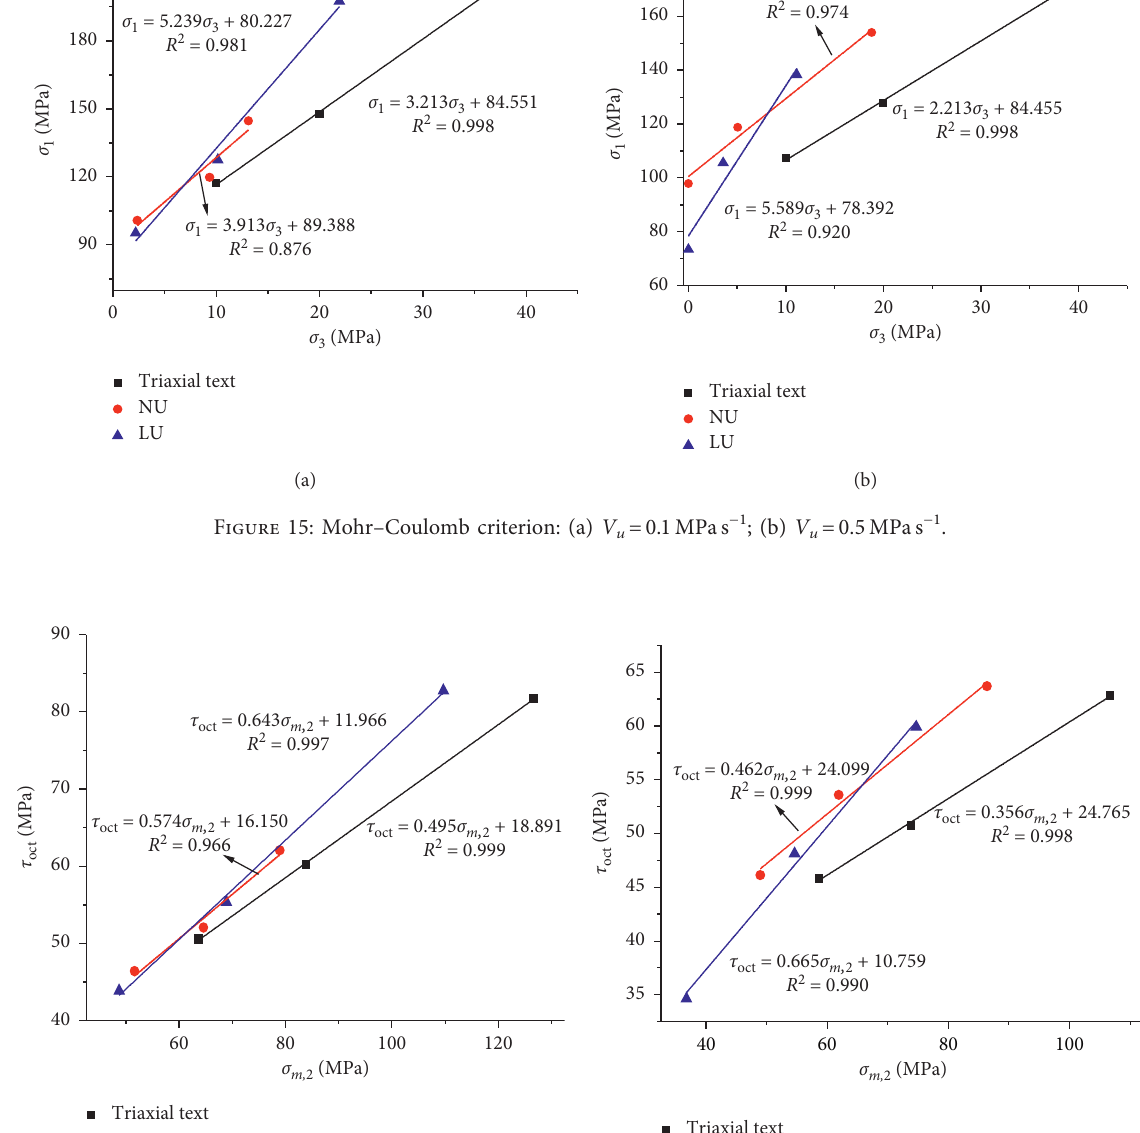
� 0.1MPa s − 1 ; (b) V u